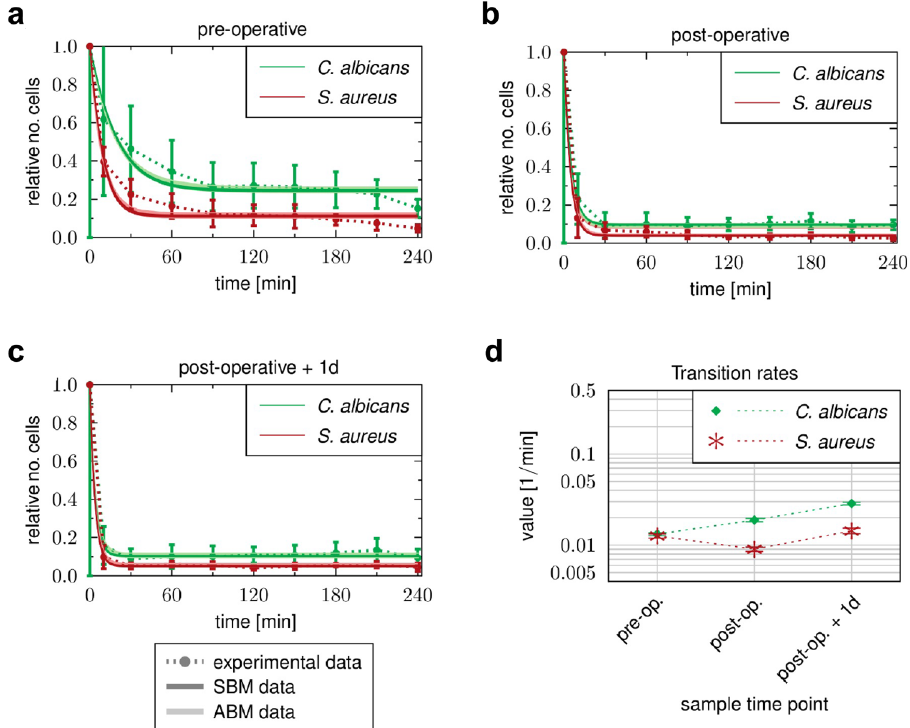
Figure 7. Time courses of extracellular pathogens observed in whole-blood samples of HLM patients. Blood samples were taken ( a ) before cardiac surgery (pre-operative), ( b ) immediately after surgery (post-operative) and ( c ) one day after admission to intensive care (post-operative + 1d). Time-resolved experimental data (dotted line) were obtained by whole-blood infection assays with either C. albicans (green) or S. aureus (red). Data points and error bars refer to the means and SD of blood samples from six HLM patients. The simulated dynamics of the combined units (solid line) were obtained by fitting the state-based model (SBM, dark color) and the agent-based model (ABM, light color) to the experimental data. The thickness of the results from the SBM represents the SD obtained by 50 simulations with transition rate values that were sampled within their corresponding SD. The thickness of the results from the ABM represents the SD obtained from 30 stochastic simulations of the ABM with the estimated diffusion coefficients. ( d ) Transition rate values for immune evasion ρ of the SBM resulting from fitting the model to experimental data of either C. albicans or S. aureus infection in blood samples from HLM